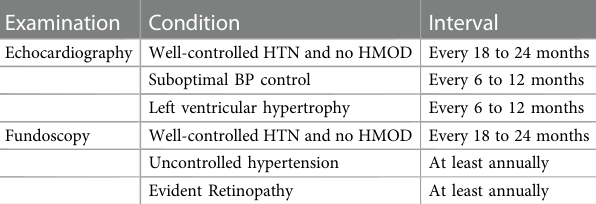
TABLE 12 Follow-up evaluation for HMOD in children with hypertension.